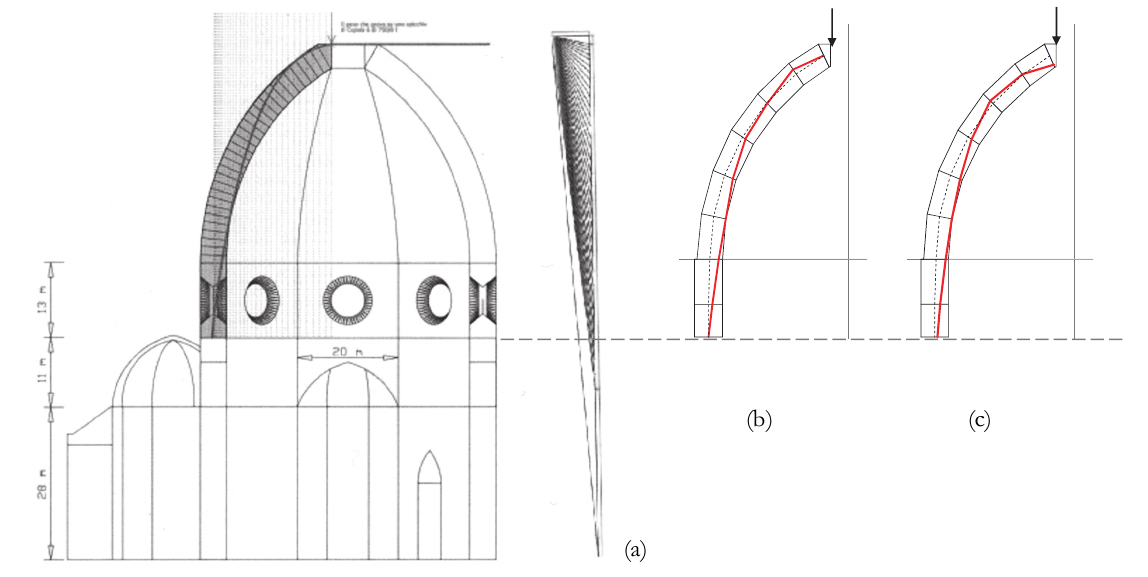
Figure 20: Comparison between our pressure curves and that of Como [19]. (a) Curve in [19]. (b) Curve obtained by imposing that it intercepts the center of the section at the drum base. (c) Curve obtained by imposing the thrust assumes the value referred in